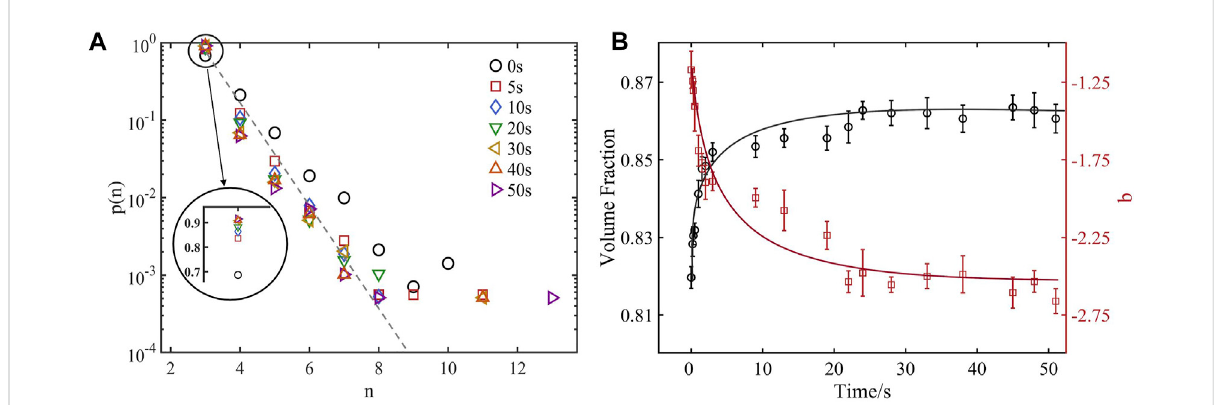
FIGURE 5 In fl uence ofvibration on structural characteristicsofdiskparticles; (A) Cell orderdistribution ofdiskparticlesundervibration; (B) The change of the volume fraction and the fi tting parameter b of the disk particles system under